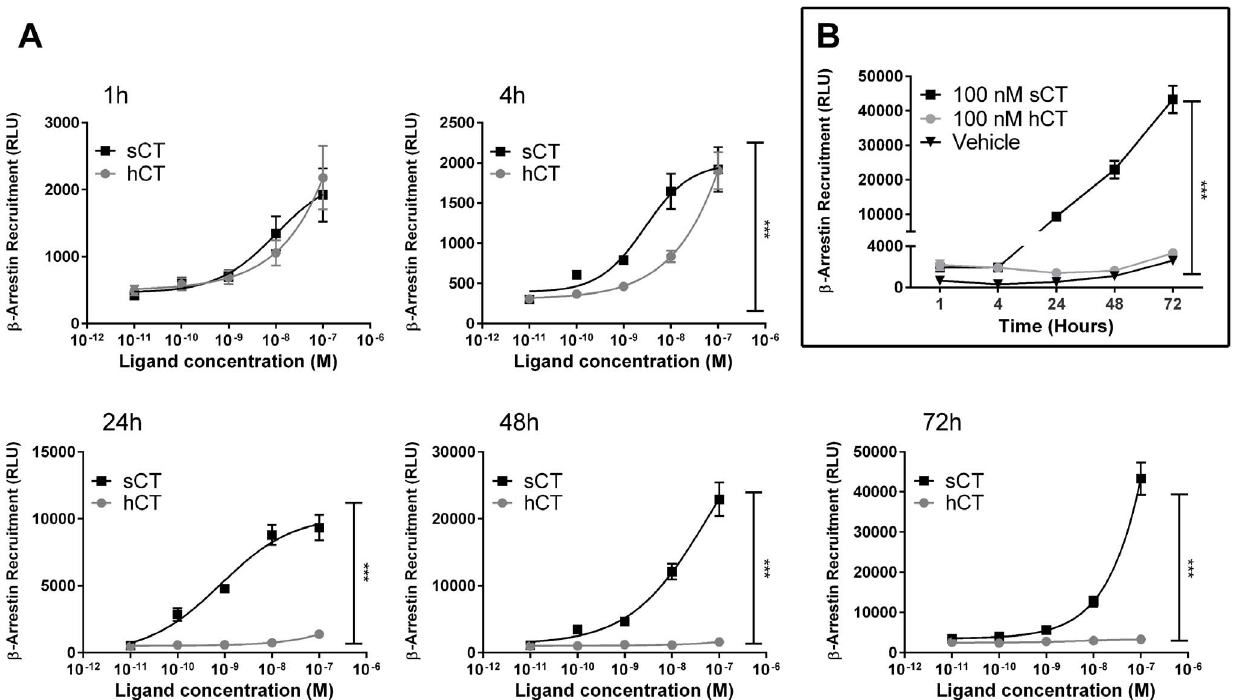
Figure 3. Difference in CT (a) R-mediated b -arrestin recruitment by prolonged continuous hCT and sCT stimulation. A) Data show b - arrestin recruitment as a function of ligand concentration. U2OS CALCR cells were stimulated with sCT or hCT at a dose range of 0.1 nM to 100 nM for a prolonged period of time, ranging from 1, 4, 24, 48 to 72 hours. Ligands and medium were only added at the experiment initiation. B) Single dose of 100 nM sCT, 100 nM hCT and Vehicle shown in (A) plotted as a function of time. Asterisk (*) indicate significant difference between AUC sCT and AUC hCT, p , 0.05 was considered to be significant. * =p , 0.05, ** =p , 0.01, *** =p , 0.001. Data are shown as mean 6 SEM of 3 experiments performed with five replicates.